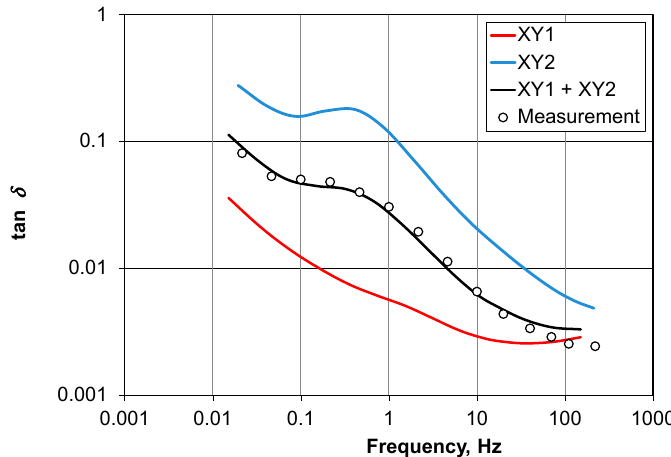
Figure 11. Loss tangent for 220 kV voltage insulator, Hitachi type OS, measured and modelled using the 2 XY model, taking into account the axial temperature distribution. Upper part temperature, 8 °C; oil temperature in the upper layer, 29 °C.